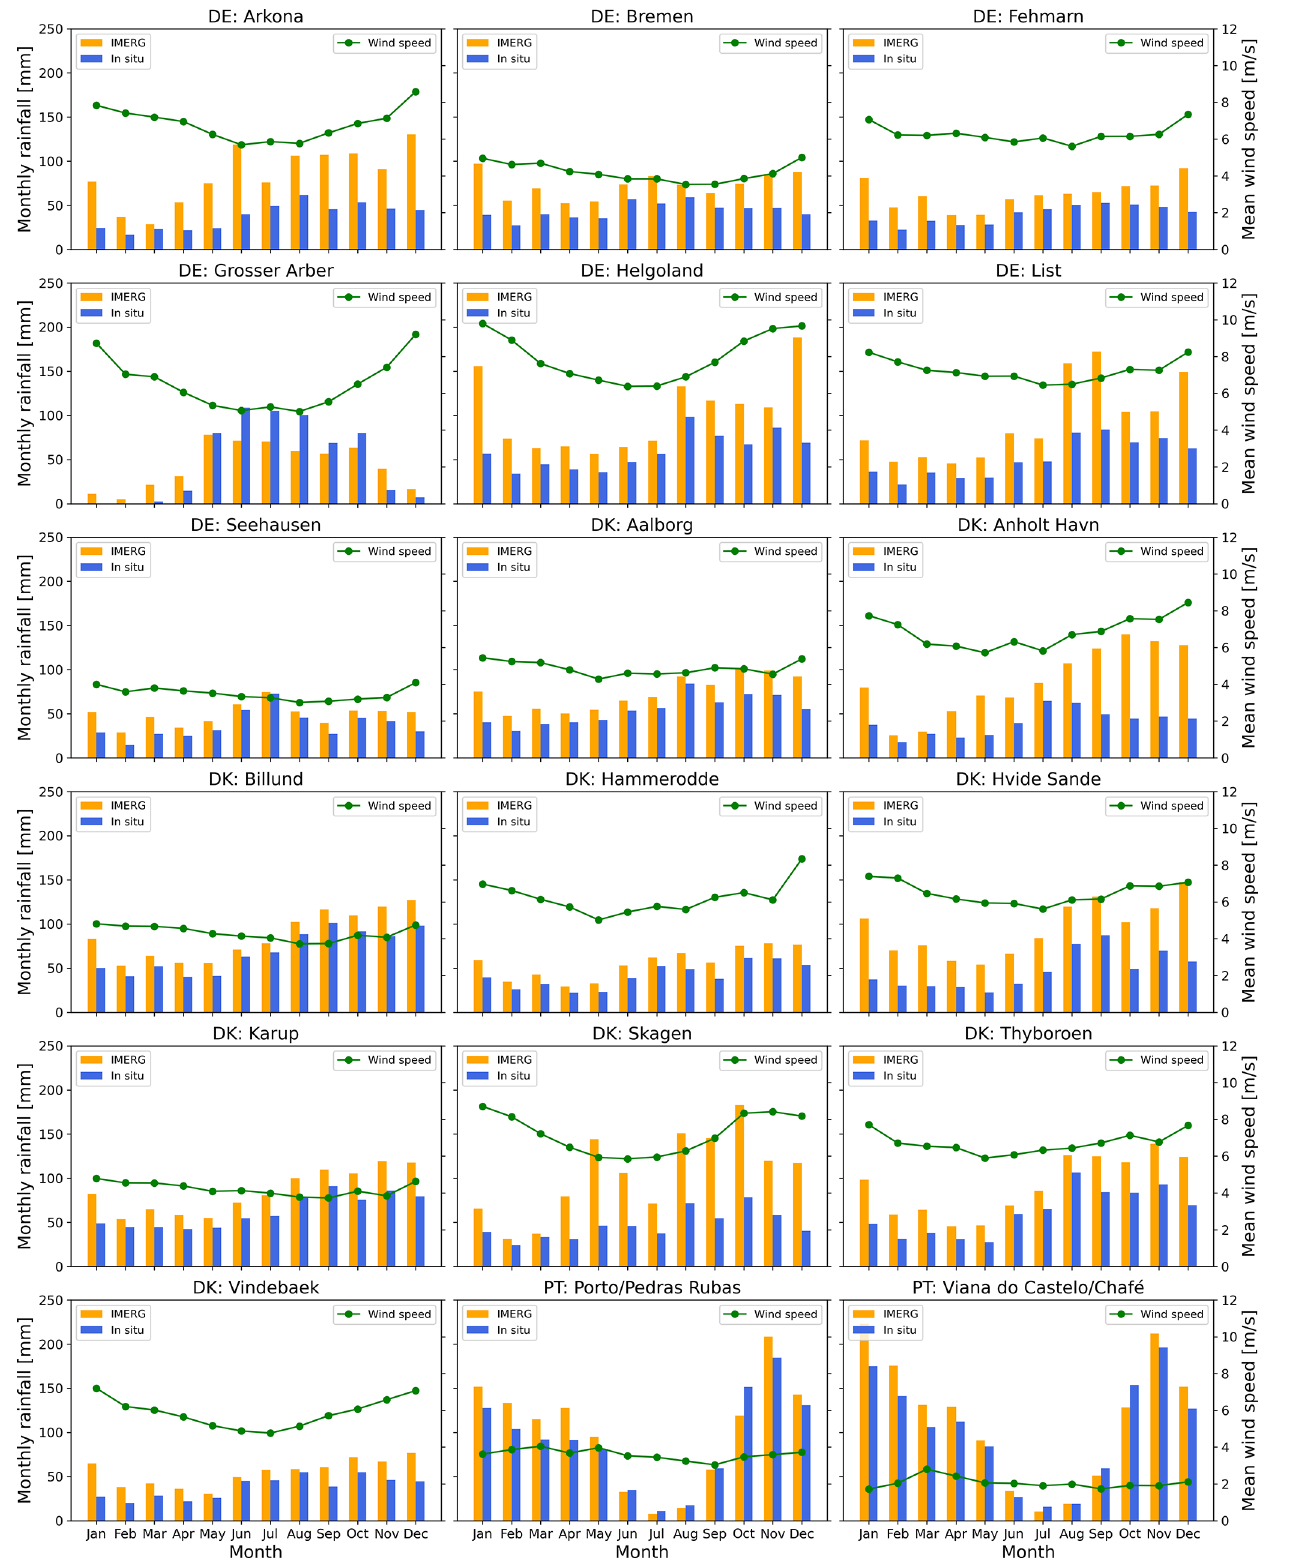
Figure 6. Monthly rainfall from IMERG and in situ observations (bars) and monthly mean wind speeds from in situ observations (green curves) averaged over 2014–2019 for the 18 stations